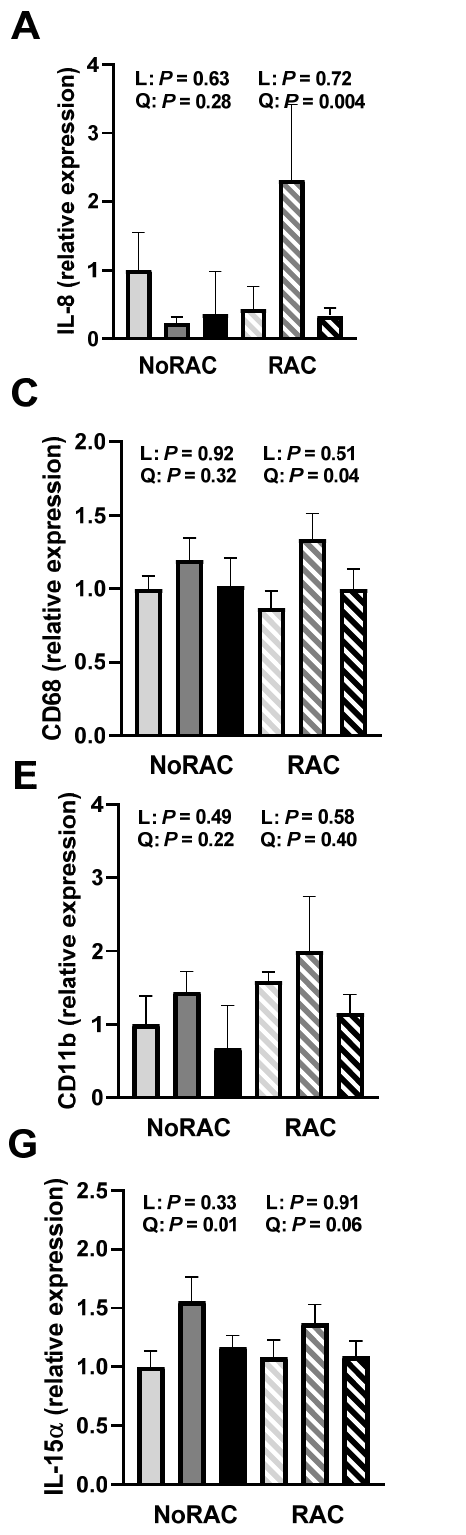
Figure 3. Relative gene expression (quantitative real-time PCR) of markers of inflammation in the muscle from steers fed 0, 10, or 20 mg Cu/kg DM for LO, MED, and HI, respectively and 0 (NoRAC) or 300 (RAC) mg · steer − 1 · day − 1 of ractopamine hydrochloride. Muscle samples (longissimus thoracis) were collected on day 66 or 67 (day 6 or 7 of RAC feeding). All mRNA relative expression were calculated relative to LO-NoRAC treatment. ( A ) Interleukin-8 (IL-8) gene expression quadratically increased with increasing Cu supplementation within RAC ( p = 0.004). ( B ) Chemokine C-X-C motif receptor 1 (CXCR1)